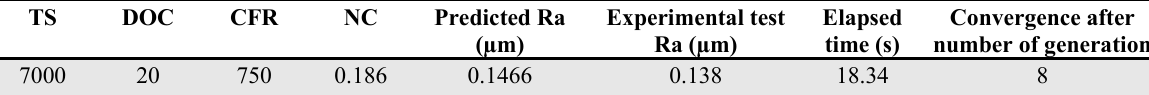
Fig. 5. Convergence graph of surface roughness of EN31 soft steel Optimal values and confirmation experiments of soft steel using Jaya